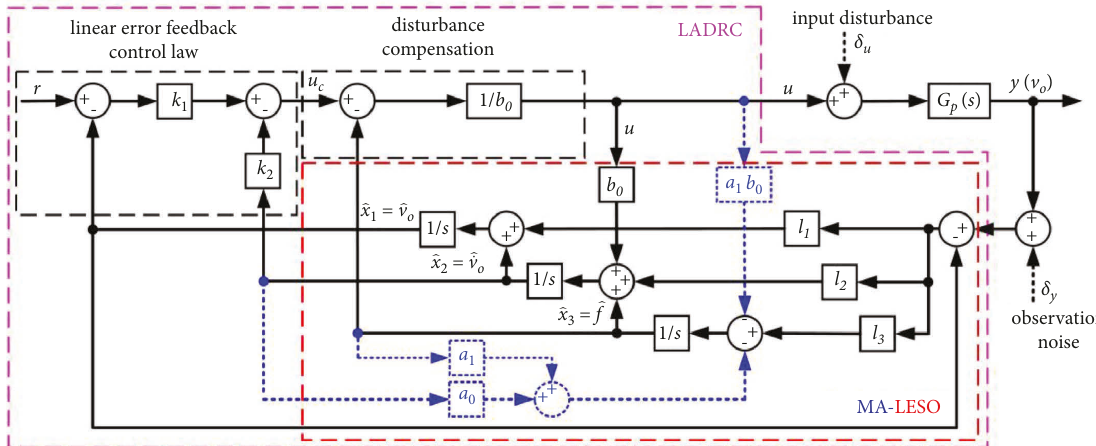
Figure 3: Control block diagram of LADRC for the single-phase inverter.